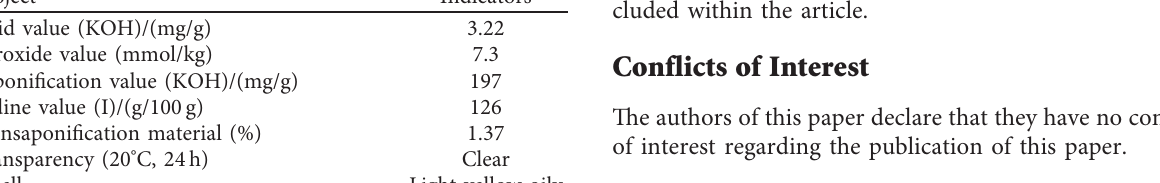
Table 11: Physical and chemical properties of palm seed oil. Project